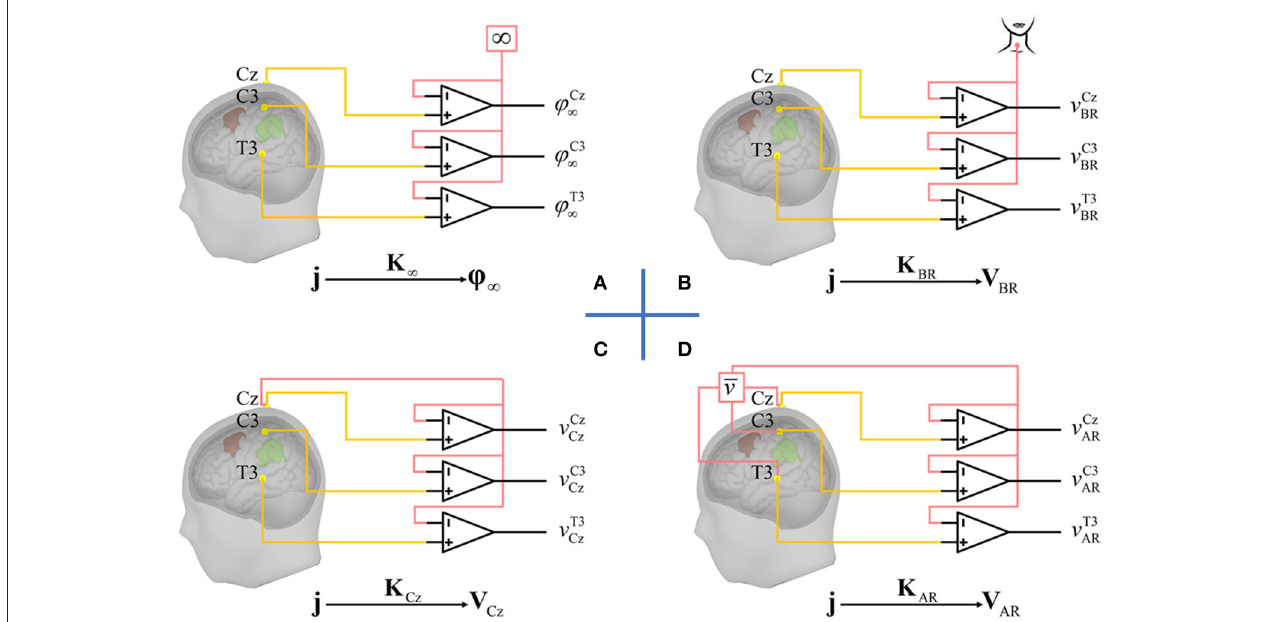
FIGURE 1 | EEG reference problem. EEG recordings measure the potential differences between active electrodes marked in yellow (only 3 for illustration) and reference marked in red which may be (A) a point at infinity, (B) an electrode placed on the body, e.g., the base of neck, (C) the cephalic reference (here, Cz), and (D) average reference: the mean of potentials over all active electrodes. All reference techniques (B–D) attempt to approximate infinity reference in (A) . The issue is that all the proposals results in different EEG waveforms originating the “EEG reference problem.” It should be noted that with the identical source activities j , the different waveforms ( ϕ ∞ , v BR , v Cz , v AR ) could be taken as well as the outcome of different lead fields ( K ∞ , K BR , K Cz , K AR